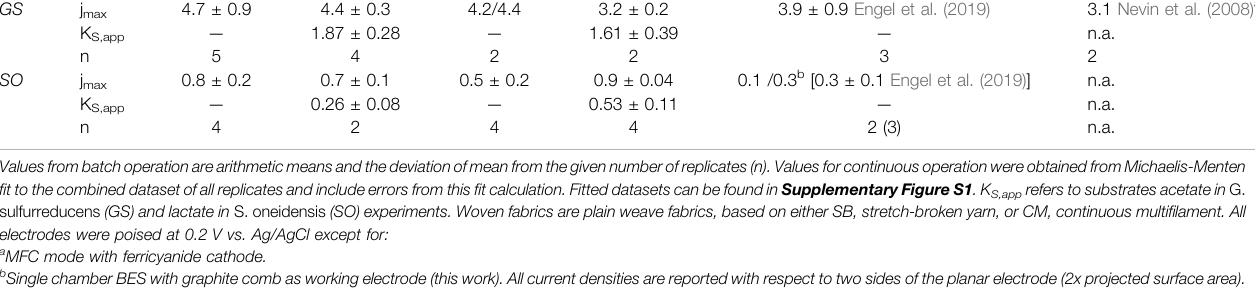
Frontiers in Chemical Engineering |